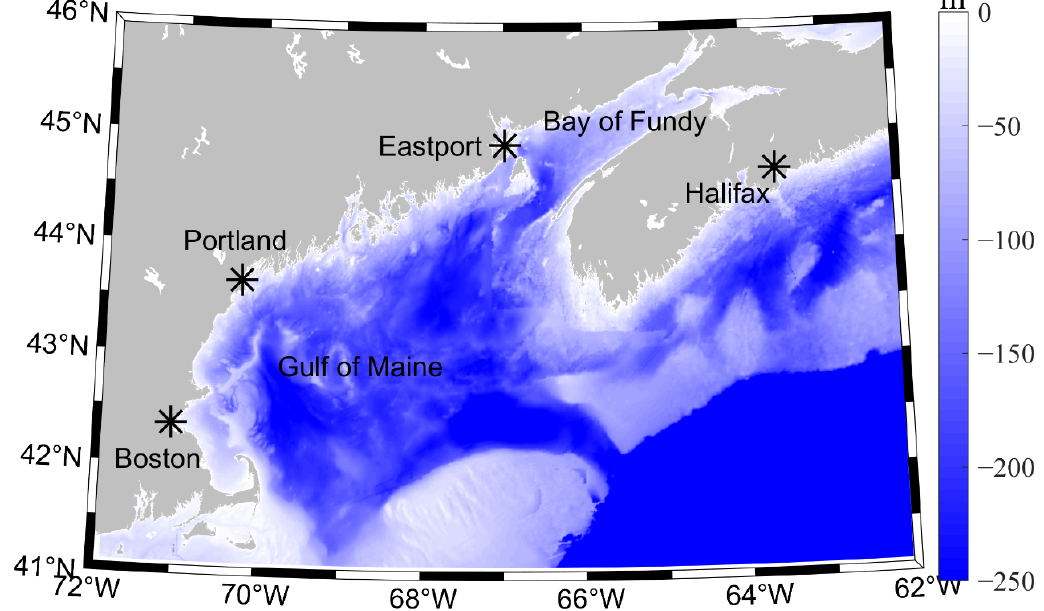
Table 2. Average amplitudes of the seven main tidal constituents at four tide gauges.